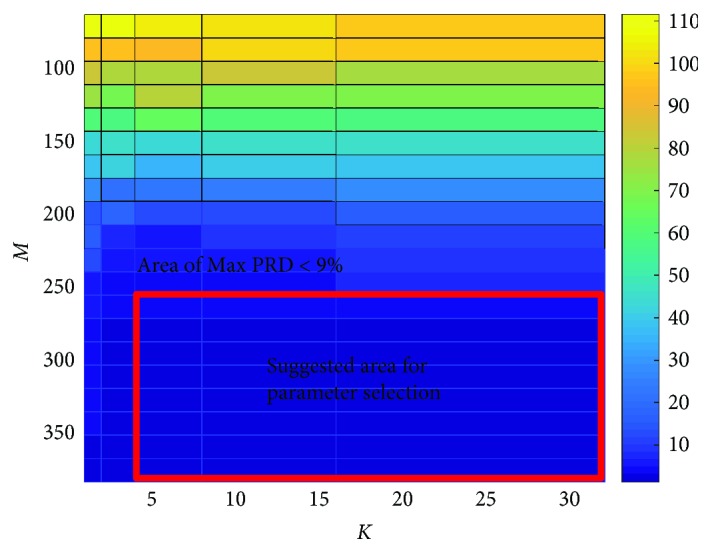
The relationships of signal distortion (PRD), compression efficiency (M), and computation complexity (K).